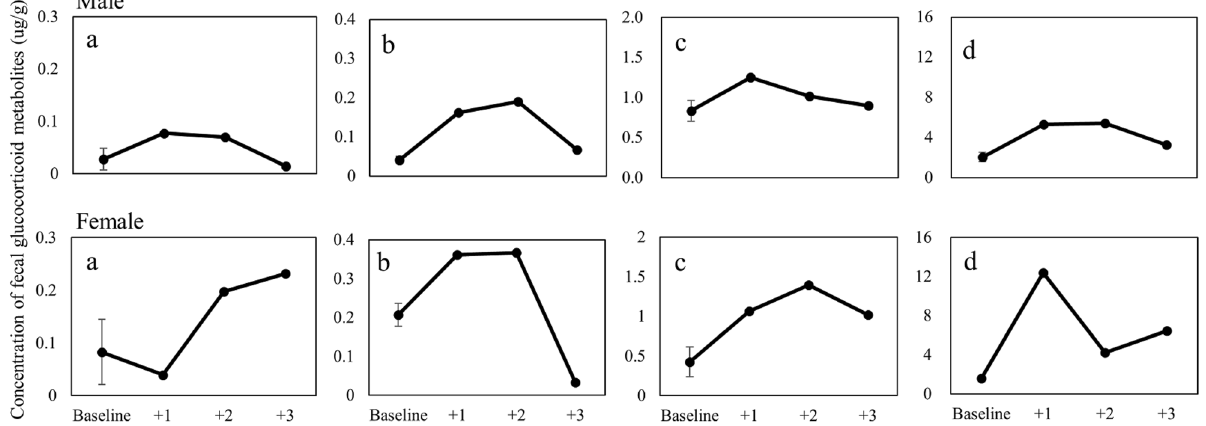
Figure 6. Concentrations of FGMs before and after anesthesia stimulation of one male and one female Formosan macaque measured using four EIA assays. The baseline values were average readings of feces collected before anesthesia with standard error. ( a ) Cortisol; ( b ) corticosterone; ( c ) 11-oxoetiocholanolone; and ( d )